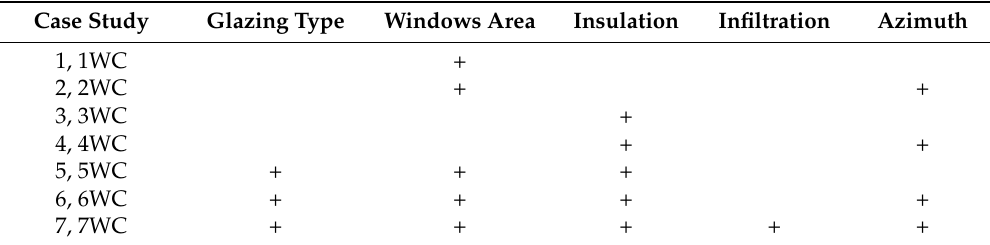
Table 5. Optimization cases.